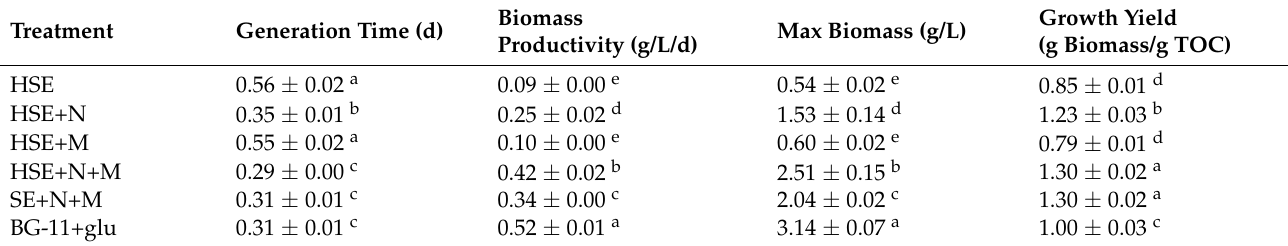
Table 3. Growth kinetic parameters of the heterotrophic C. vulgaris